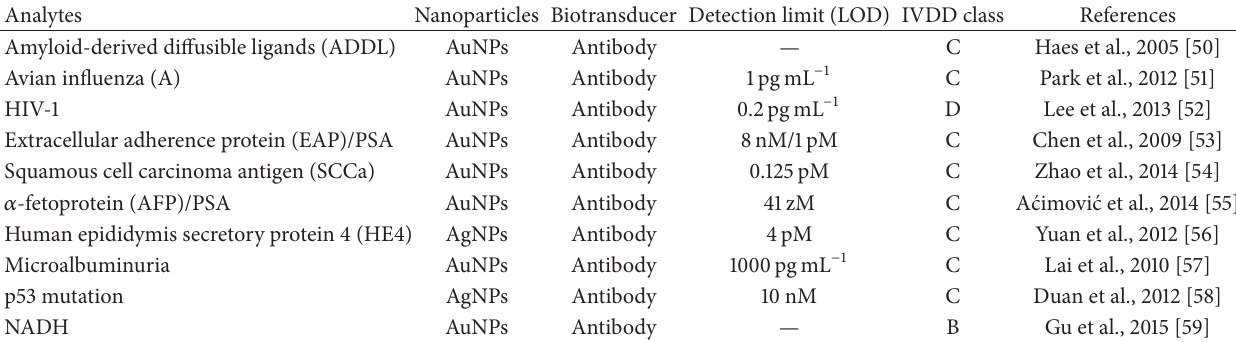
Table 4: Main analytical performances of the reviewed biosensors based on localized SPR.